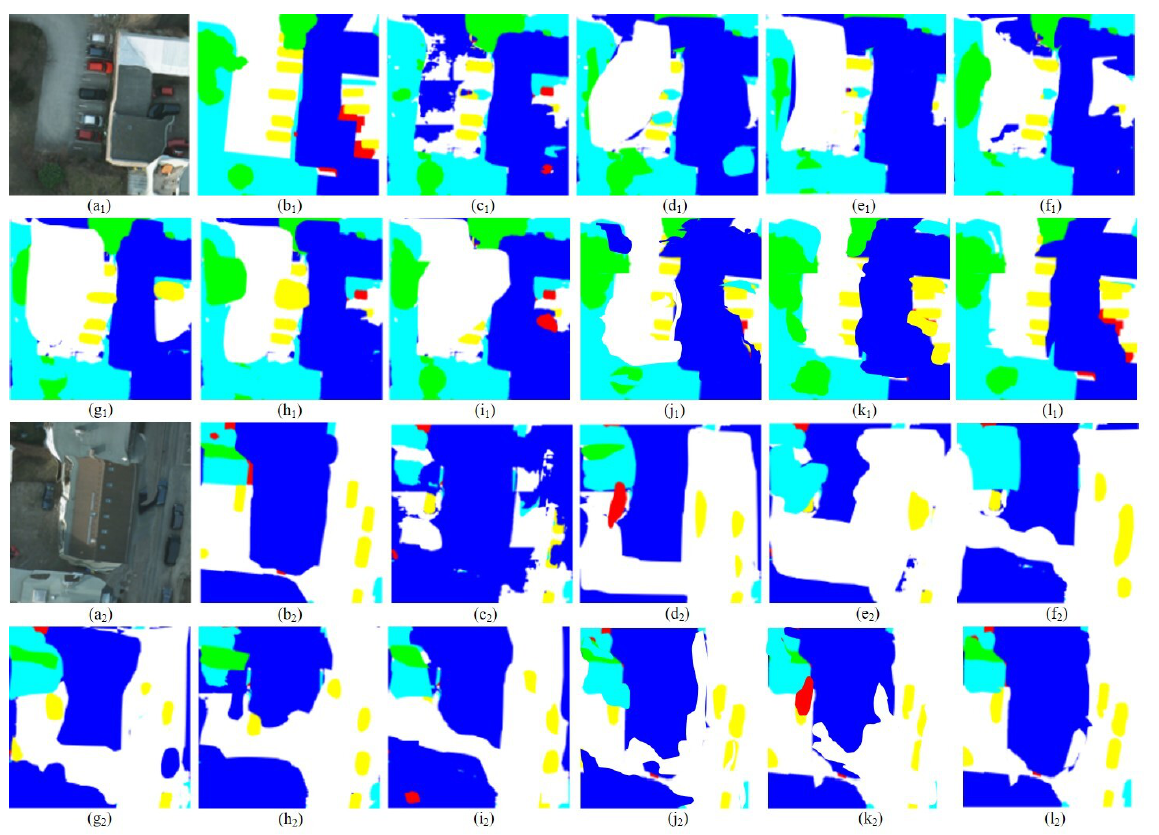
Figure 19. Semantic segmentation results on Potsdam. ( a1 , a2 ) Original image, ( b1 , b2 ) ground truth, ( c1 , c2 ) U-Net, ( d1 , d2 ) SegNet, ( e1 , e2 ) PSPNet, ( f1 , f2 ) HRNetV2, ( g1 , g2 ) DeepLab V3+, ( h1 , h2 ) Tran- sUnet, ( i1 , i2 ) SegFormer, ( j1 , j2 ) Inception-ResNetV2, ( k1 , k2 ) Swin Transformer, and ( l1 , l2 ) MCAFNet.